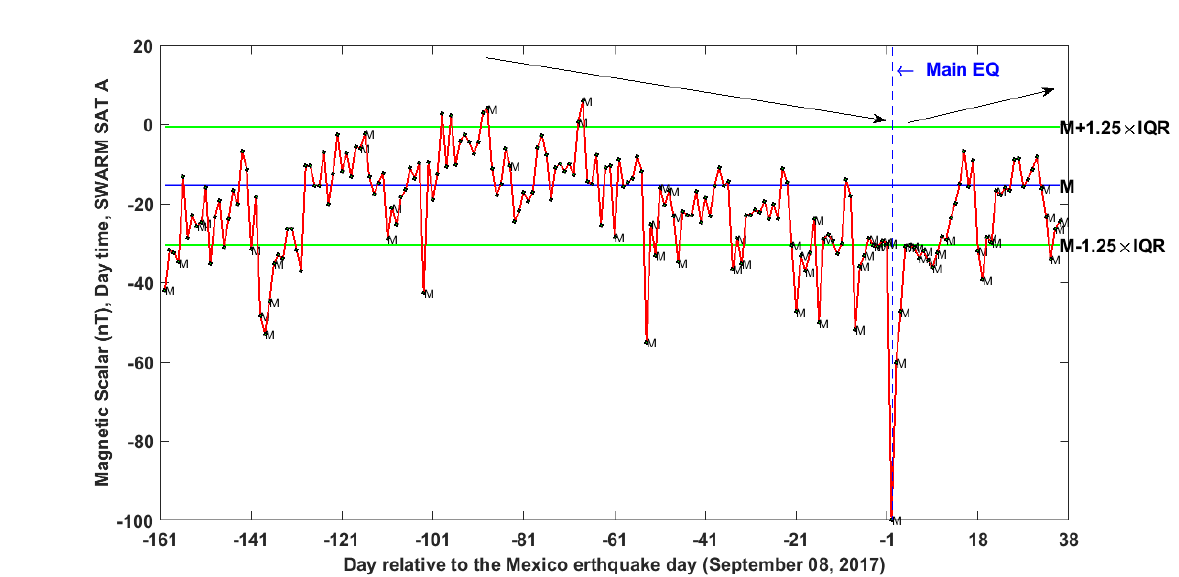
Fig. 1. Results of Swarm A scalar magnetic field data analysis for the Mexico earthquake (08 September 2017) from 01 April to 15 October 2017. The earthquake day is represented as vertical line. The green horizontal lines indicate the upper and lower bounds ( I Q R M   25 . 1 ). The blue horizontal line indicates the median value ( M ). The values of the median and the allowable bounds were calculated only using the quiet geomagnetic days. The x-axis represents the day relative to the earthquake day. They- axis represents the daytime scalar magnetic field median values for each day. respectively. The track crossed the Dobrovolsky’s area between the 04:21:41 and 04:39:54 UTC. The horizontal and vertical axes represent the geographic longitude and latitude coordinates, respectively. The differences between the time- series of the first derivatives of the measured magnetic fields scalar and vectors (X, Y, Z) values and a fitted polynomial of degree 12 along this track are shown in Figures 4 (b, c, d and e) respectively. The vertical axis represents the geomagnetic latitude. Every four time series of the residual curves of the scalar and vector components show anomalous variations around the earthquake location (the red arrows in Figure